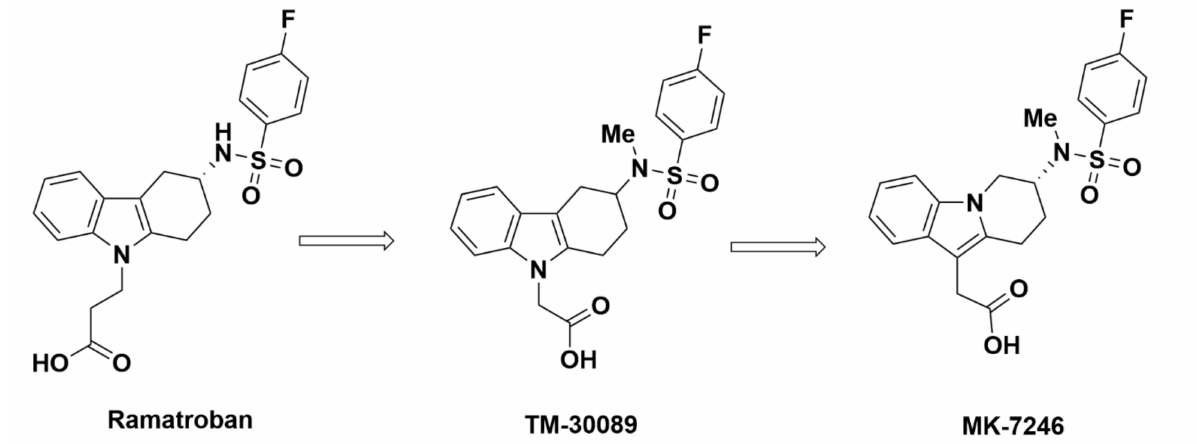
Figure 6. Molecular structure and synthesis of MK-7246 from ramatroban . Administration of MK-7246 to mouse, rat, dog, sheep, and rhesus and cynomolgus monkey orally and intravenously demonstrated a good overall 24 h pharmacokinetic pro- file [70]. Favorable oral bioavailability above 50% was found in all species (F = 109%, 114%, 67%, and 57%, respectively), except in cynomolgus monkey for unknown reasons (F = 10%). While low plasma clearance following intravenous administration was observed in mouse (t 1/2 = 2.8 h), rat (t 1/2 = 5.6 h), rhesus monkey (t 1/2 = 8.1 h), and sheep (t 1/2 = 6.5 h),